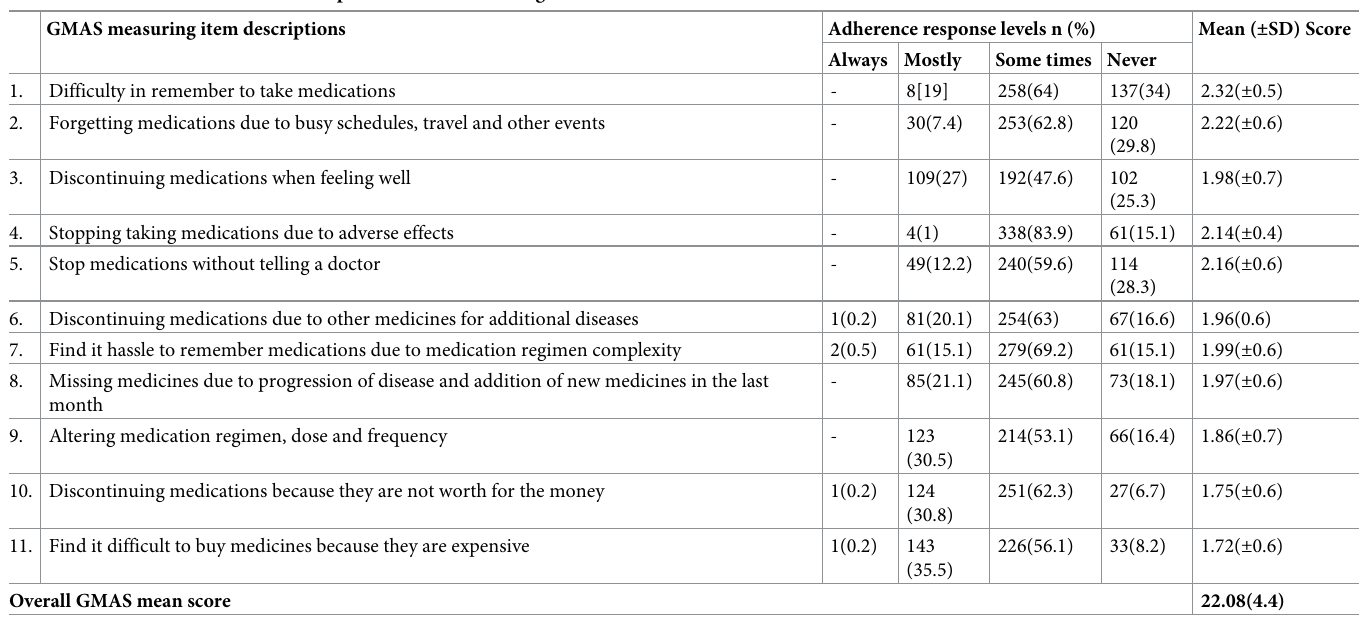
Table 3. Medication adherence with respect to GMAS measuring items.